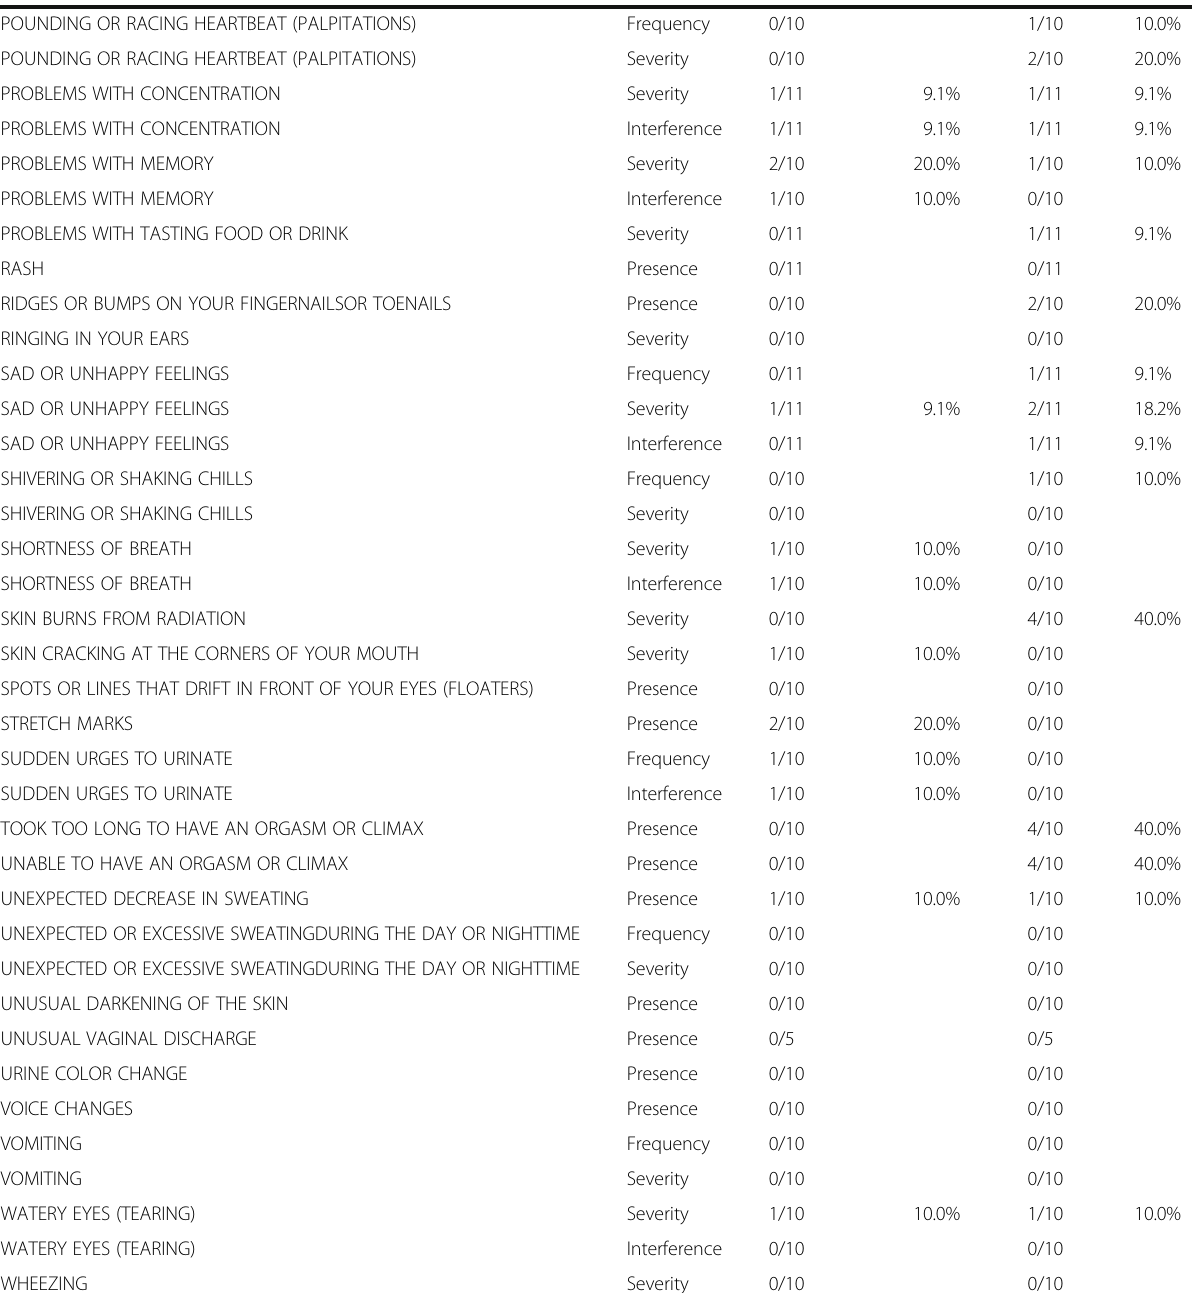
Table 2 Proportion of patients who evaluated items as “ difficult to understand ” or “ difficult to answer ” (Continued) POUNDING OR RACING HEARTBEAT